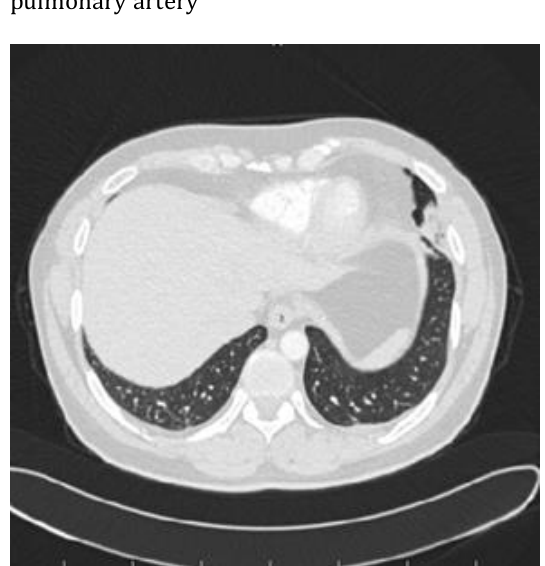
Figure2: Infiltration in left